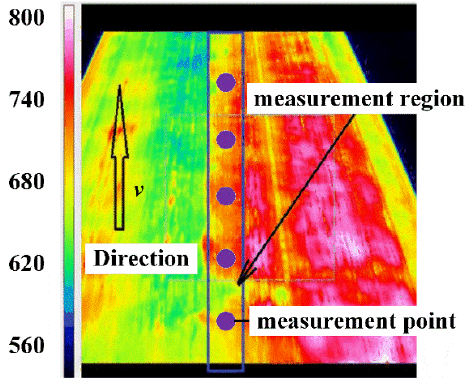
Figure 12. Temperature distribution measured by the thermal imager and the measurement region of the pyrometer.